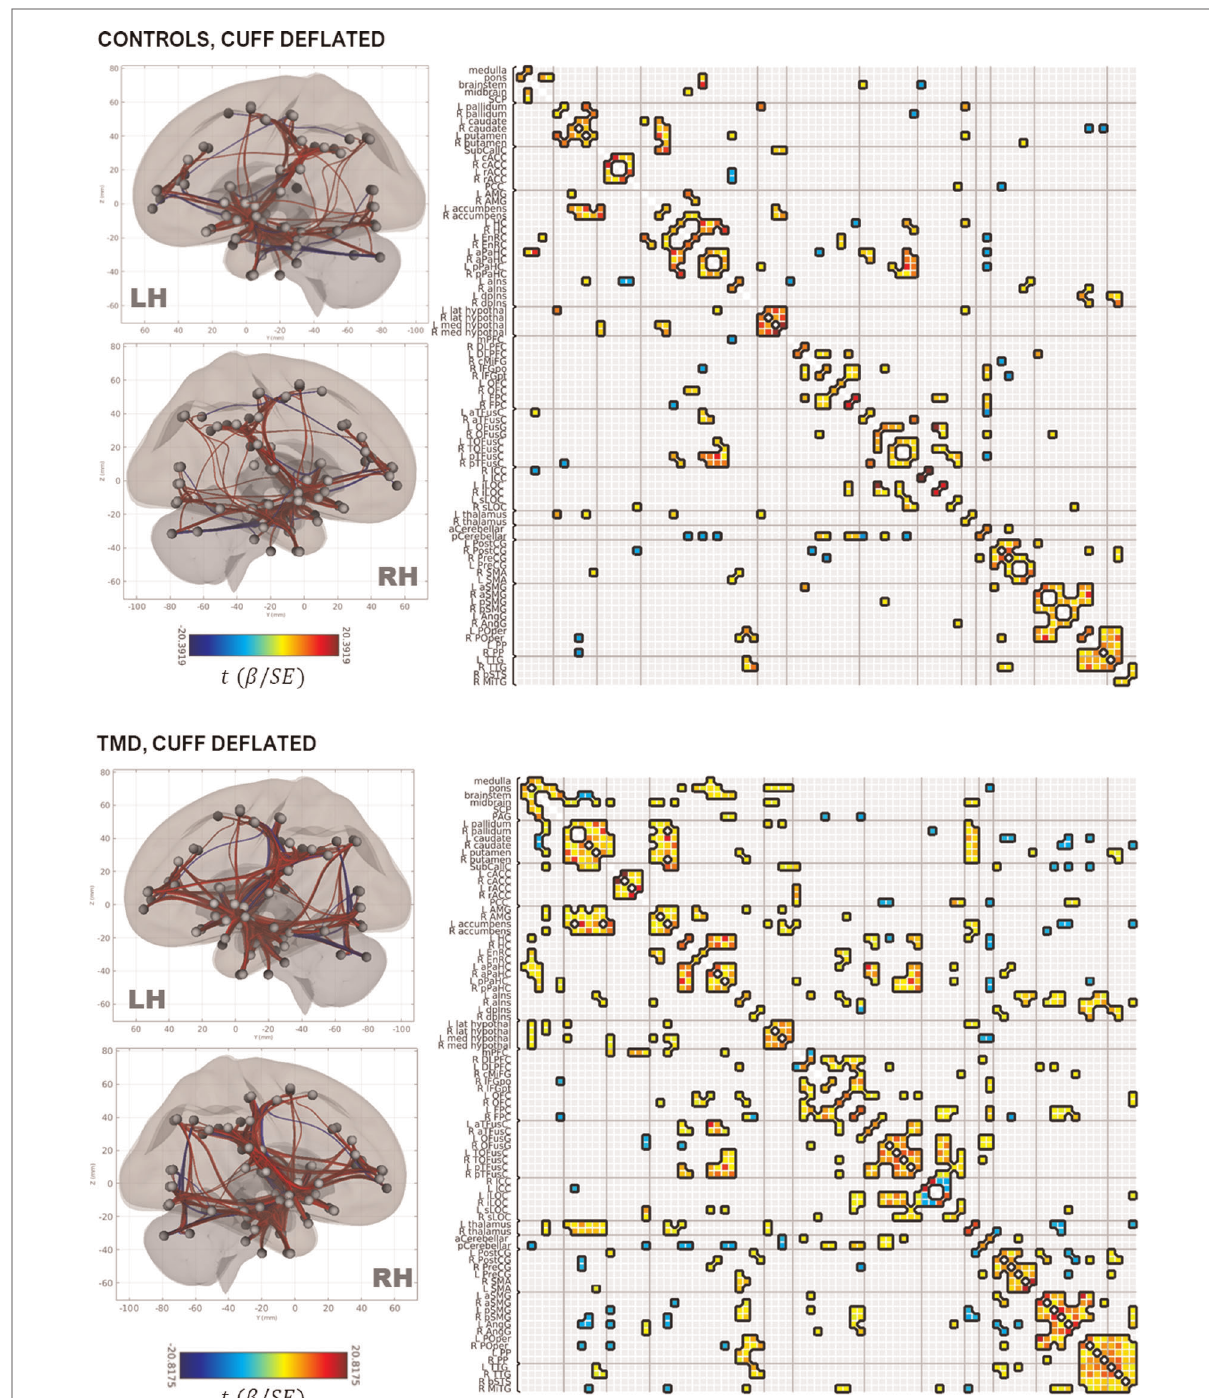
FIGURE 2 Rendering of functional connectivity networks and correlation matrices for connections surviving one-sample t -tests in control ( top panel ) and TMD participants ( bottom panel ) in the cuff-de fl ated condition. The color bar corresponds to the Wald t -statistic for each connection (the general linear model regression coef fi cient divided by its standard error). Negative, or blue, values represent negative or antiphase correlations between ROIs, whereas positive, or red values represent positive or in-phase correlations between ROIs. ROI abbreviations are de fi ned in Supplementary Table S1